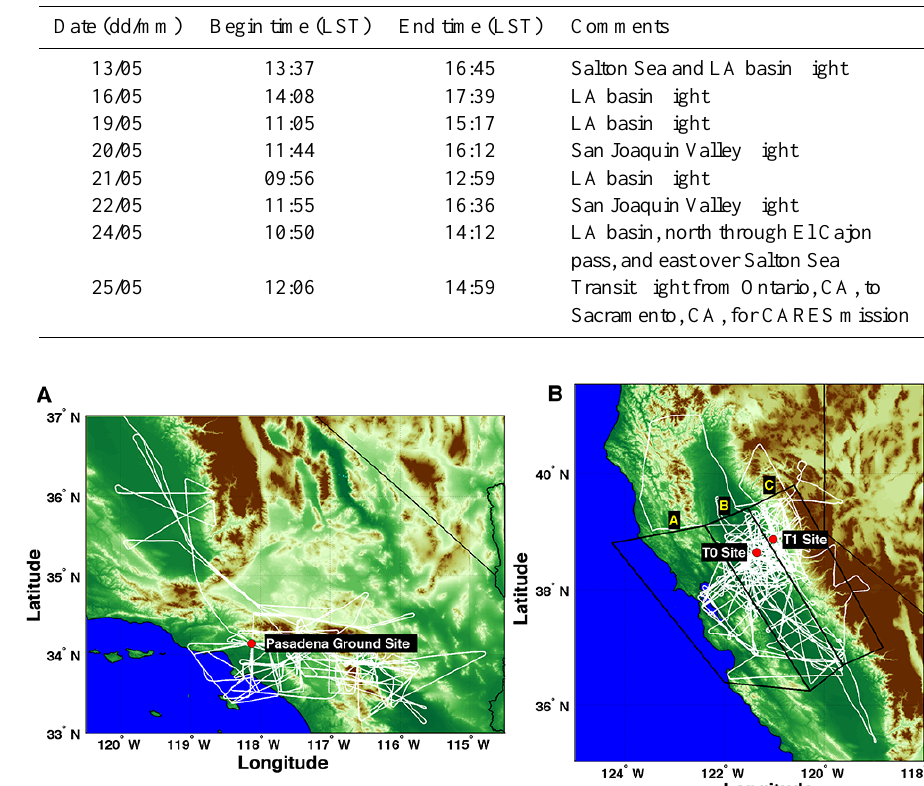
Table 1. Summary of HSRL flights during CalNex. Ceilometer data is available on all flight days.